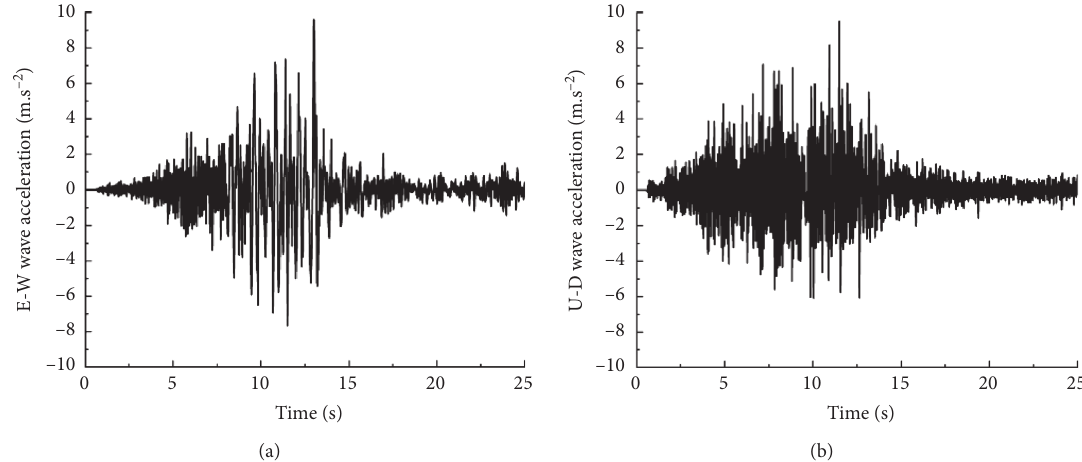
Figure 5: Model input seismic wave acceleration time history curve. (a) E-W wave curve (M1, M2, and M3). (b) U-D wave curve (M4) (the dataset is provided by China Earthquake Networks Center, National Earthquake Data Center (http://data.earthquake.cn)).